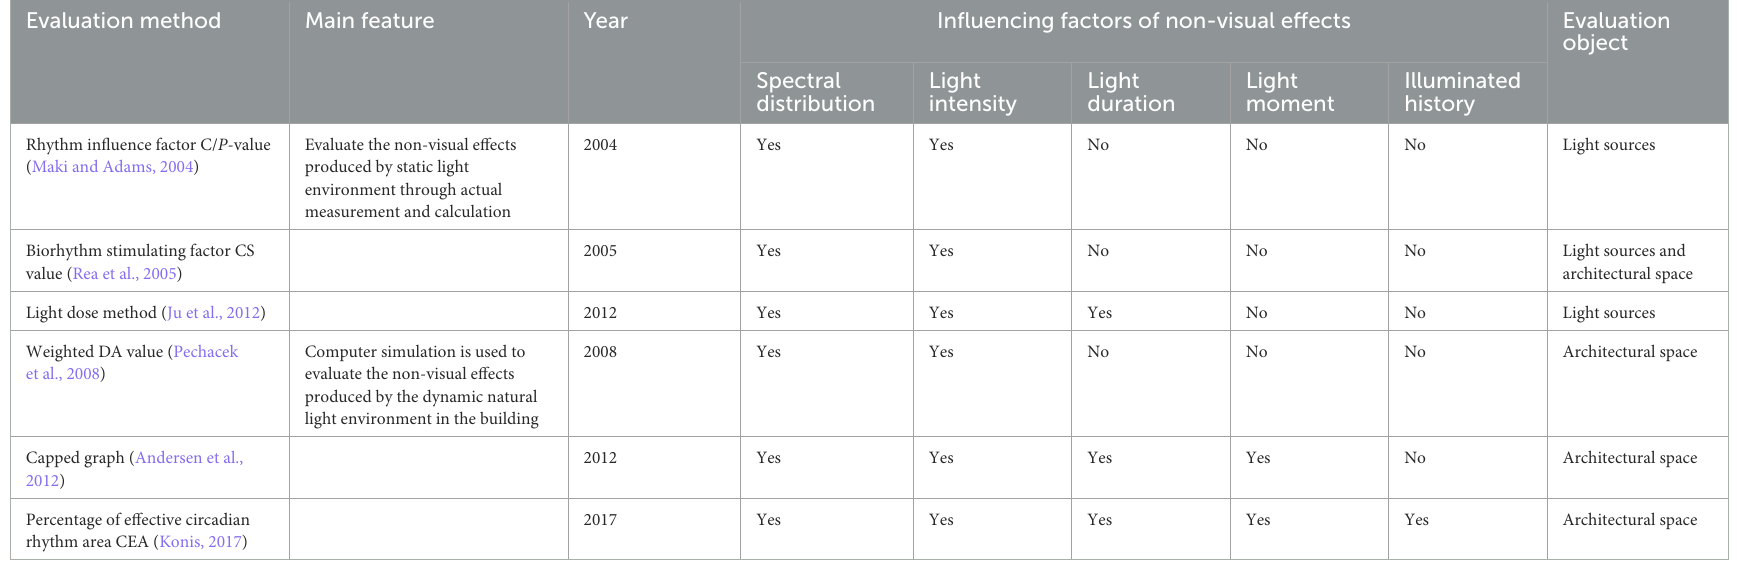
TABLE 2 Summary of evaluation methods examining the non-visual effects of light.